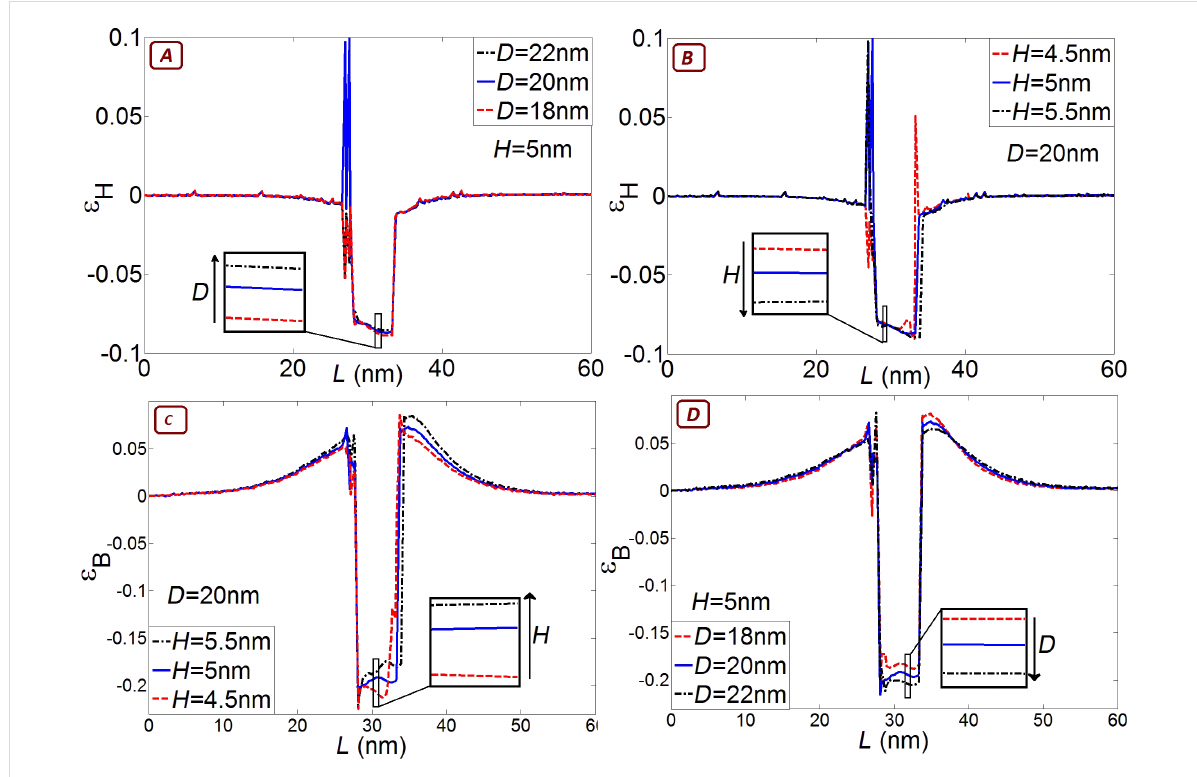
Figure 9: Hydrostatic ε H and biaxial ε B strain with different dimensions along a line through the middle of the quantum dot in the [001] direction. (A) ε H as a function of different dot diameters; (B) ε H as a function of different dot heights; (C) is ε B as a function of different dot diameters; (D) ε B as a func- tion of different dot heights. The magnitude of the biaxial strain increases with increasing diameter and decreases with increasing height, while the hydrostatic strain evolves in the opposite